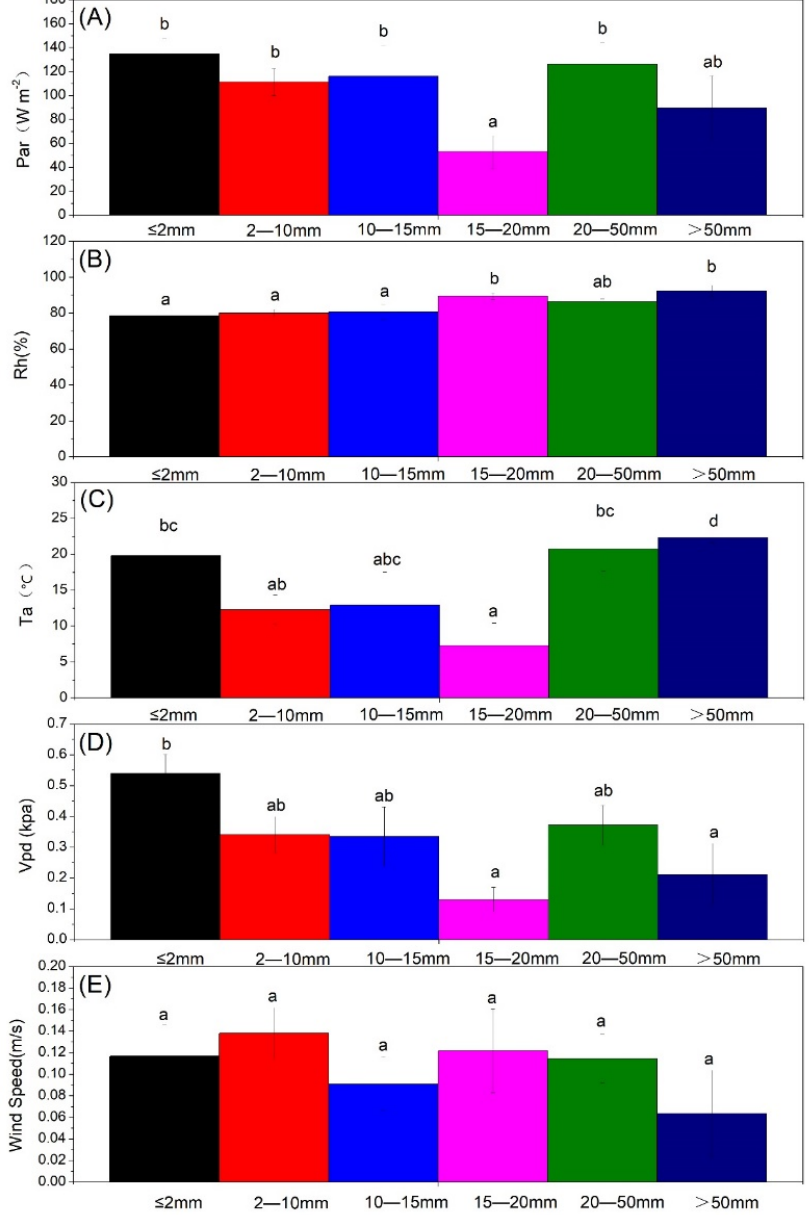
Figure 4. Environmental variables following different rainfall intensities. (Note: lower case letters indicate significant differences between different rainfall intensities ( p < 0.05)).